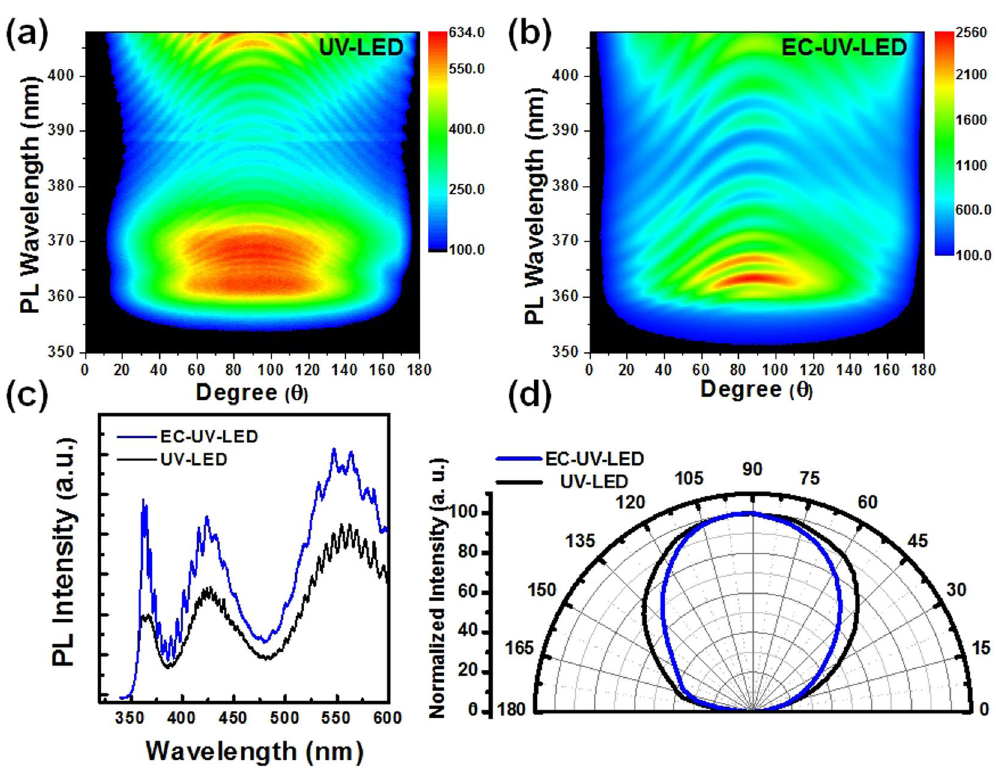
Figure 3. PL emission spectra of ( a ) the UV-LED and ( b ) the EC-UV-LED were measured through the angle- resolved PL measurements using a 325 nm diode laser as an excitation laser source. ( c ) The PL spectra of both of the LED structures were measured at normal direction (at 90°). ( d ) Normalized PL far-field radiation pattern of both of the LED structures were